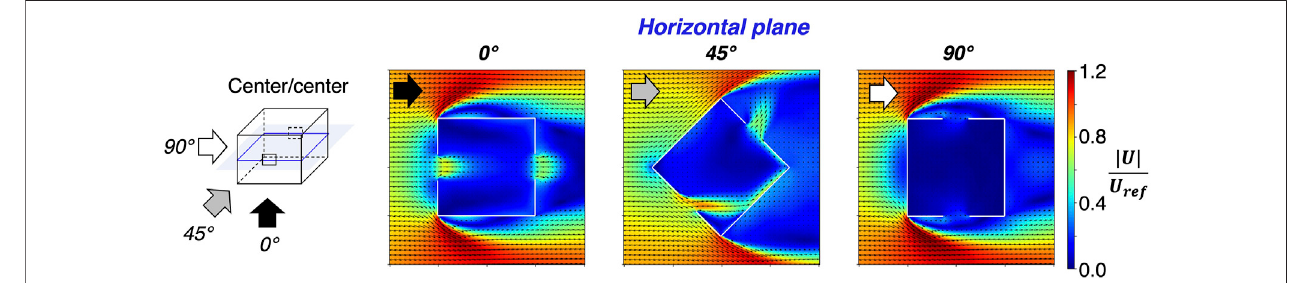
FIGURE 6 | Velocity magnitude and direction on horizontal planes across openings in the center/center con fi